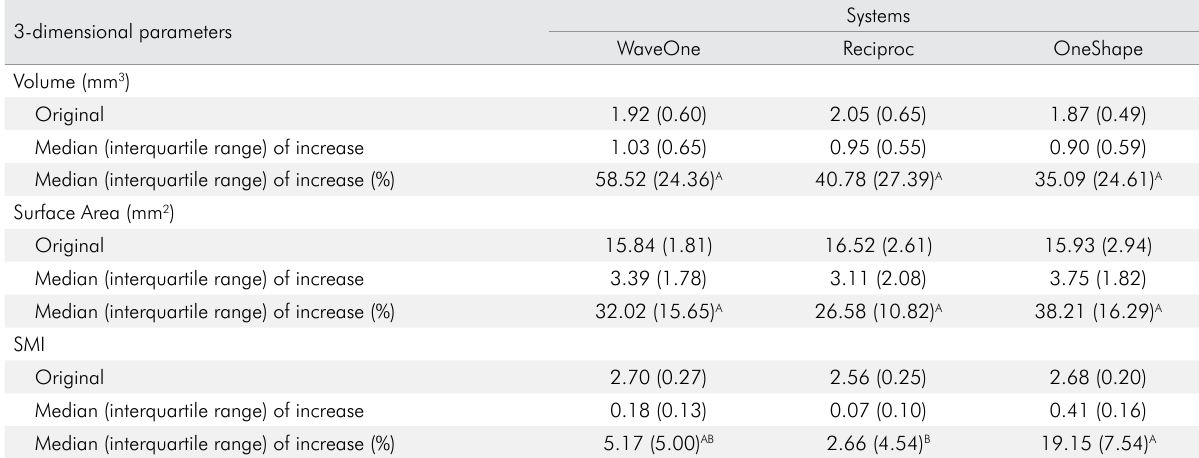
Table 1. Median percentage increase and interquartile range of 3-dimensional parameters measured mesial root canals of mandibular molars after preparation with the Waveone, Reciproc, and OneShape